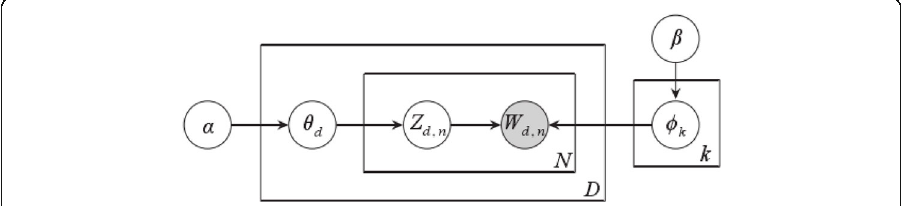
Fig. 1 The latent Dirichlet allocation topic